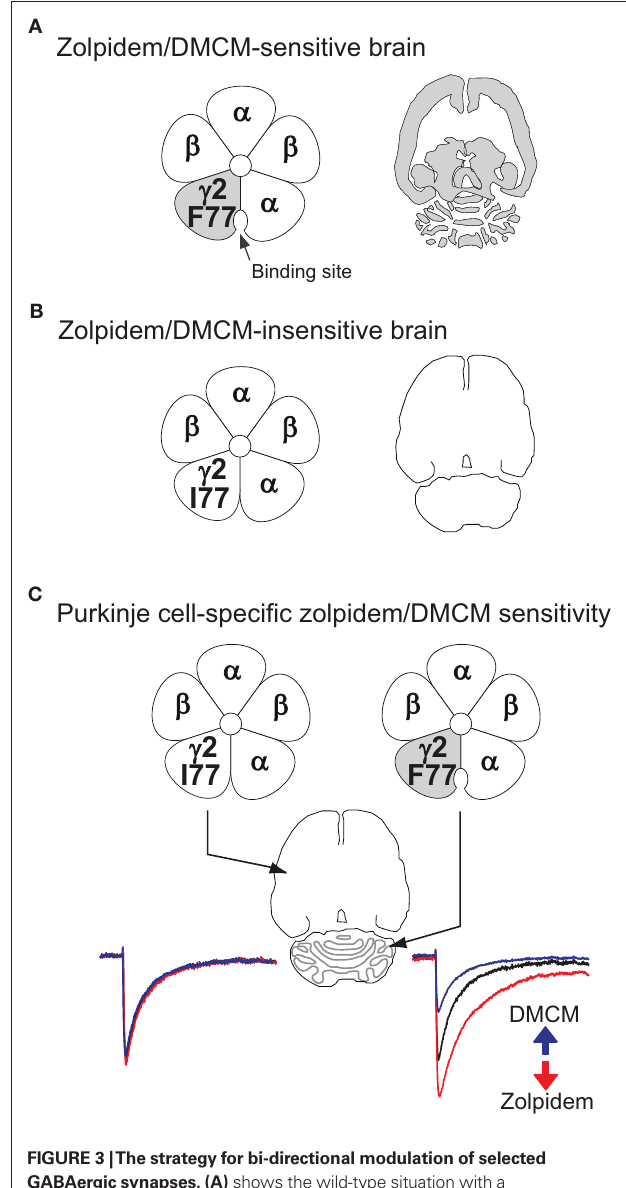
FIGURE 3 | The strategy for bi-directional modulation of selected GABAergic synapses. (A) shows the wild-type situation with a phenylalanine (F) at position 77 in the γ 2 subunit of the GABA receptor. A Zolpidem/DMCM binding occurs at the interface of the α and the γ 2 subunits and is widely distributed throughout the brain (indicated in grey in the cartoon of a horizontal brain section). In a fi rst step (B) we have changed the phenylalanine at position 77 to isoleucine (I) by homologous recombination in mouse embryonic stem cells. In these mice zolpidem/DMCM binding is abolished. In the last step (C) we have reintroduced the drug-sensitive wild- type γ 2 subunit under the control of the Purkinje cell-specifi c L7 promoter to selectively restore zolpidem/DMCM-sensitivity by a Cre-mediated Purkinje cell-specifi c swap of γ 2 subunits (PC- γ 2-swap mice). In these mice expression of zolpidem/DMCM-sensitive GABA receptors is restricted to A Purkinje cells of the cerebellum (grey). Note the difference to wild-type mice in (A) , which show drug binding throughout the cerebellar cortex. In Purkinje cells zolpidem (red trace) and DMCM (blue trace) now selectively enhance or reduce, respectively, GABA receptor-mediated inhibitory post synaptic A currents, illustrated by the artifi cial traces on the right (GABA alone: black trace). All other neurons in the brain are insensitive to these drugs (left